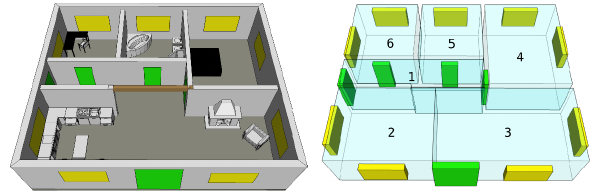
Figure 2. Possible direct and indirect correspondences between Figure 1. Space representation in IFC. An IFC model that IFC and IndoorGML classes (based on v2). represents a simple house (left) and the 6 room (cyan) as well as doors (green) and windows (yellow) spaces that give adequate IndoorGML representation for spaces and openings. Image from (Diakit´e et al., 2017).